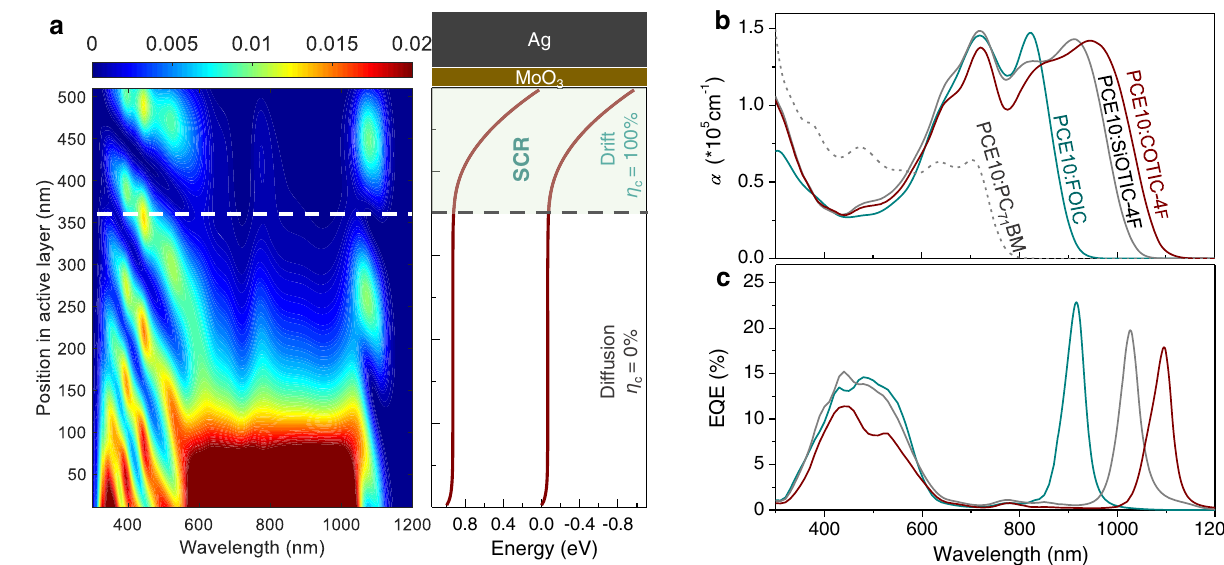
Fig. 1 | Design principle of near-infrared narrowband photo-detection. a Left: computed spectrally and spatially resolved energy absorption pro fi le of PCE10: COTIC-4F nonfullerene active layer in an inverted device architecture: ITO (135nm)/PDIN (15nm)/PCE10: COTIC-4F (500nm)/MoO 3 (15nm)/Ag (100nm). Right: a band diagram at V = 0V in the dark, calculated from a drift-diffusion simulation of the device with a n-doping density of N t = 1.88 × 10 16 cm − 3 (see simulations details in Supplementary Note 1). The n-type doping causes non- uniformelectric fi eldwithintheactivelayerofathickinvertedOPD(red).Thelight green area indicates the space-charge region where the collection of photo-